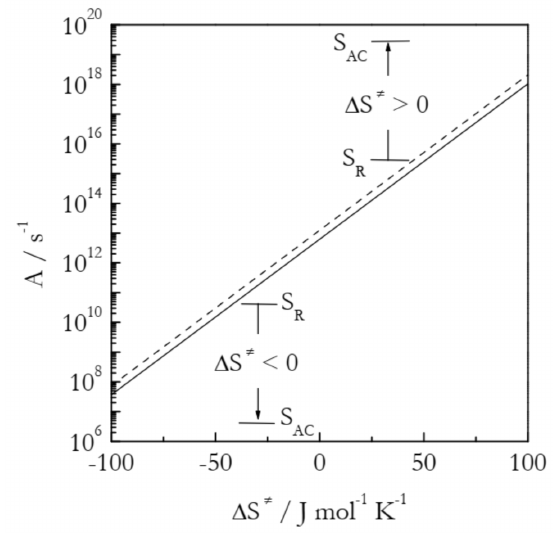
Figure 4. Preexponential factor as a function of the activation entropy at temperatures 300 K (solid line) and 600 K (dashed line). S AC and S R are the entropies of the activated complex and reactants,